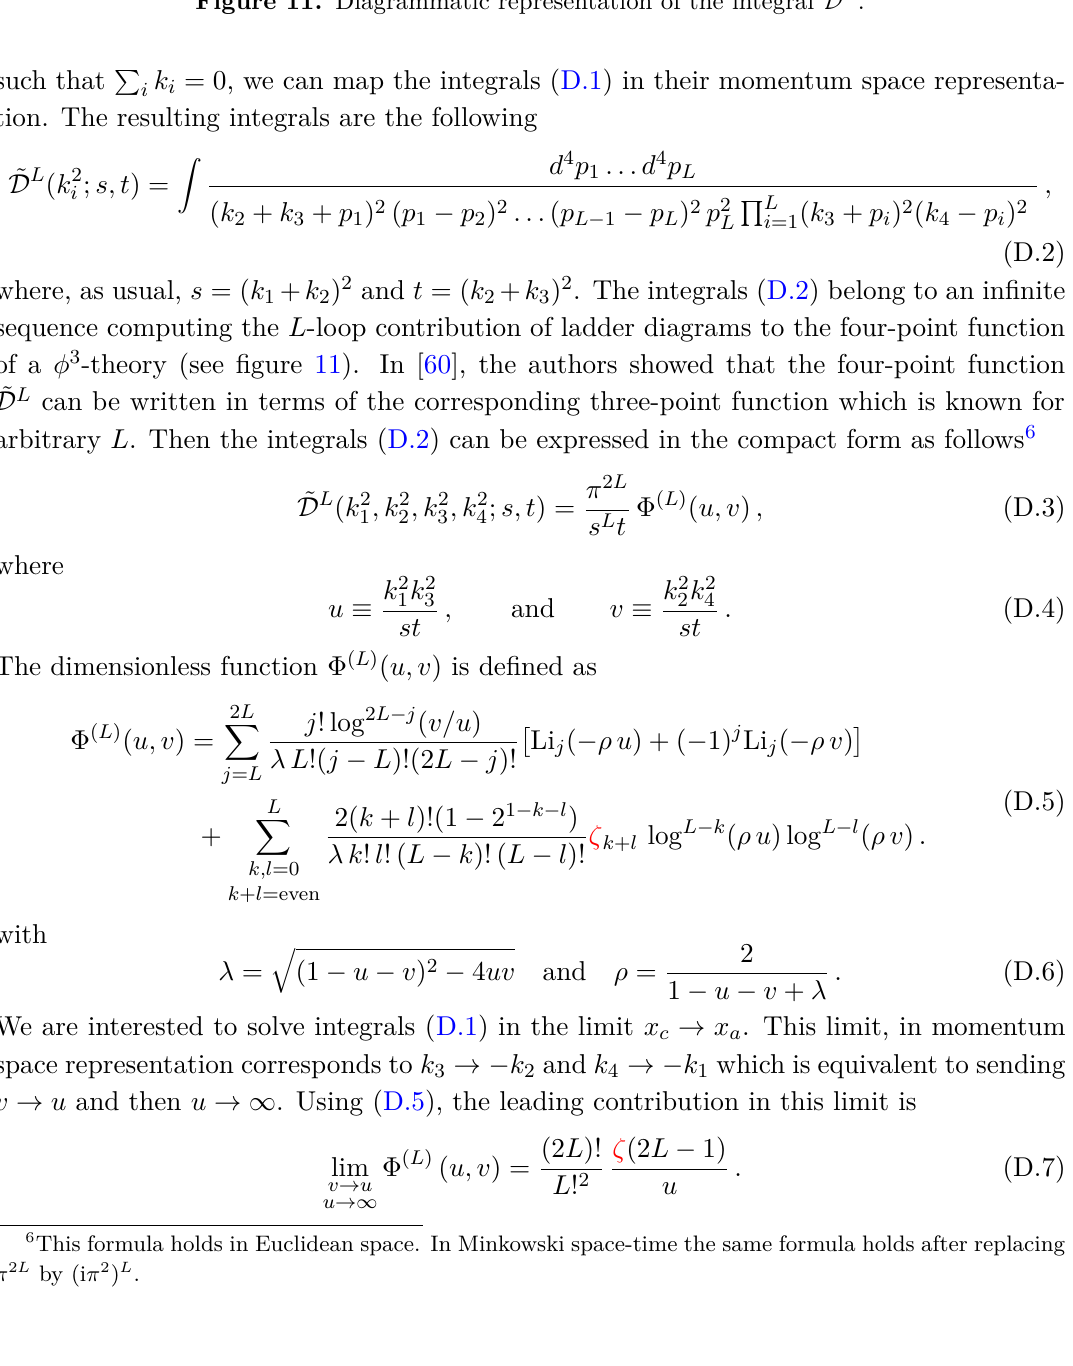
Figure 11. Diagrammatic representation of the integral